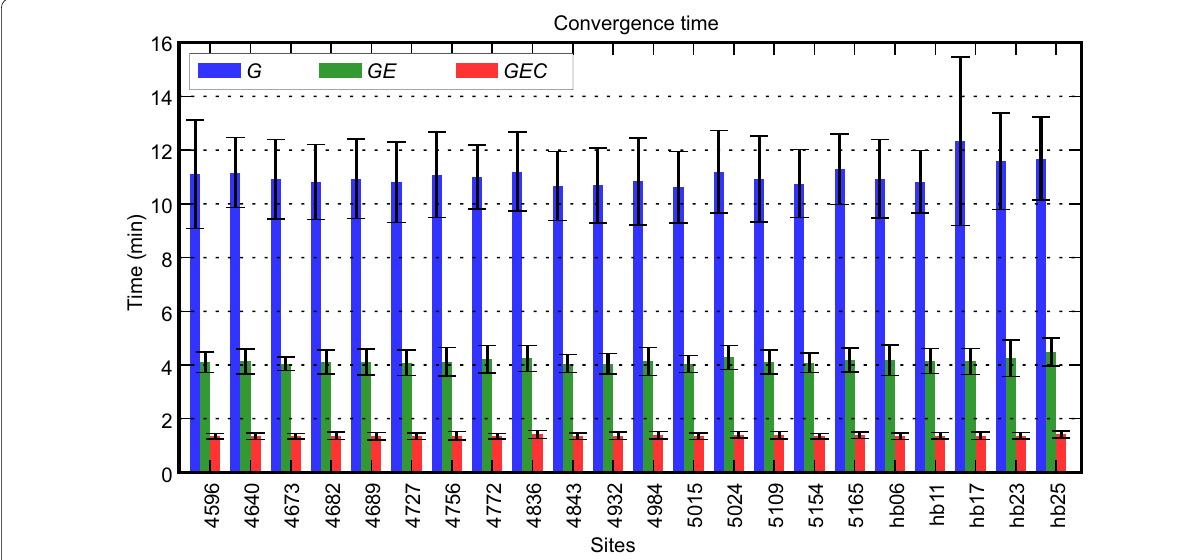
Fig. 12 Average convergence time and its variability of GPS only (blue), GPS/Galileo (green), GPS/Galile/BeiDou (red) solutions